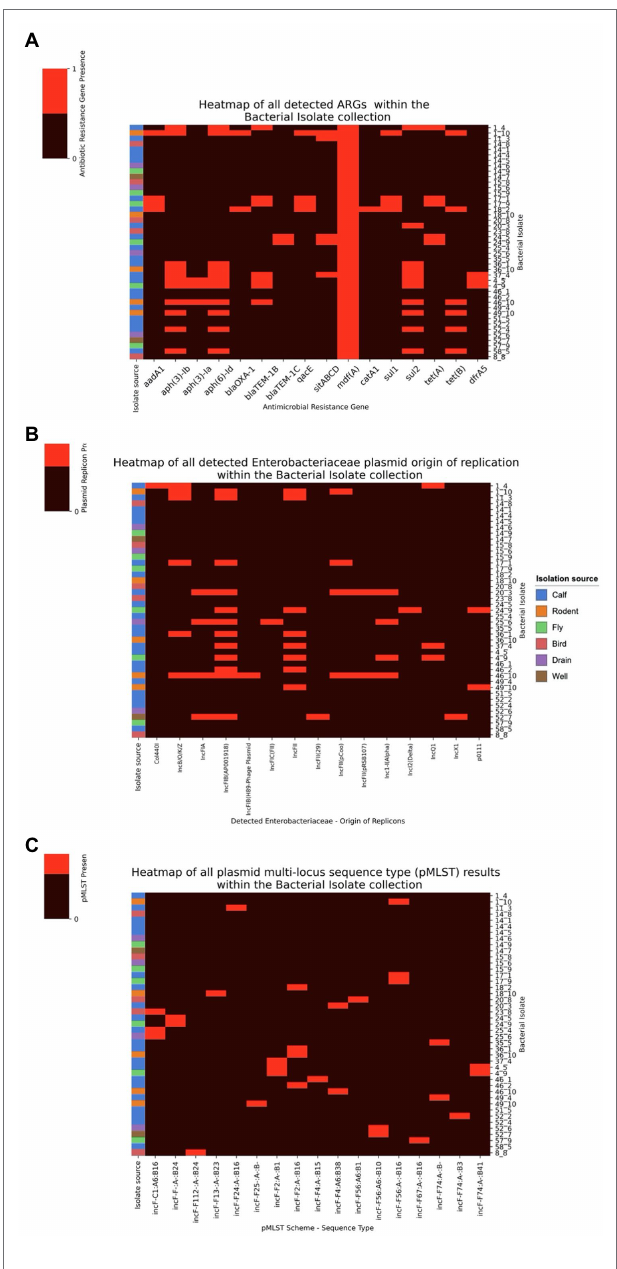
FIGURE 3 | Heatmaps showing the presence of ARGs and plasmid replicons and pMLSTs discovered in bacterial isolates from Swedish dairy farms. (A) Heatmap of all detected ARGs in the bacterial isolates with isolation source annotated in accordance to the key. (B) Heatmap of all detected plasmids origin of replications in the bacterial isolates with isolation source annotated in accordance to the key. (C) Heatmap of pMLST in the bacterial isolates with isolation source annotated in accordance to the